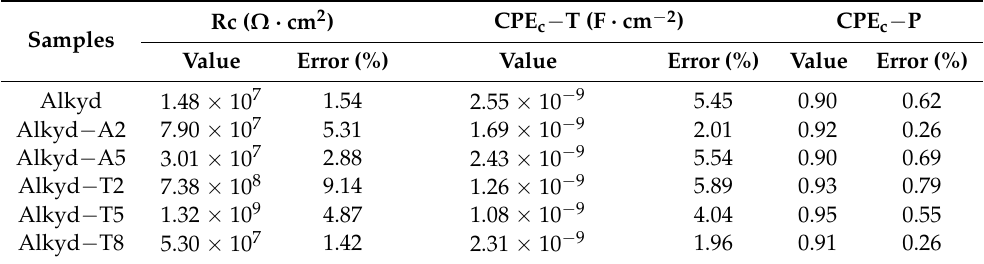
Figure 6. Impedance spectra for carbon steel coated with Alkyd ( a ), Alkyd − A2 ( b ), and Alkyd − A5 ( c ), in 3.5 wt% NaCl solution. Table 2. Electrochemical parameters calculated from EIS spectra of alkyd coatings containing PANI nanostructures immersed in 3.5 wt% NaCl